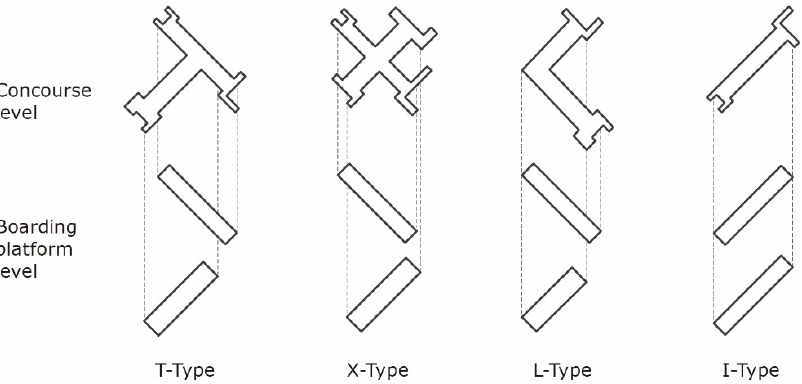
Figure 1. Typical floor plans of Taipei Metro stations.